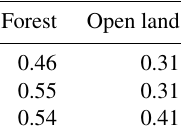
Table 1. Thresholds ( τ ) applied in Eq. (3) for the whole circumpolar area, derived from the Roy et al. (2015). Beam Tundra Forest Open